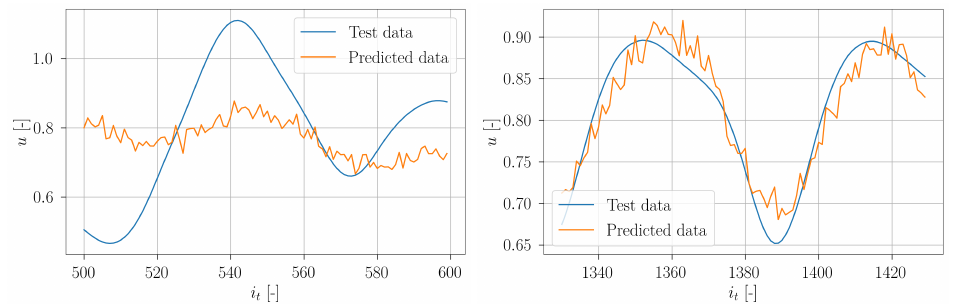
Figure 17. Timeseries reconstruction for setup 4 of the cylinder case.